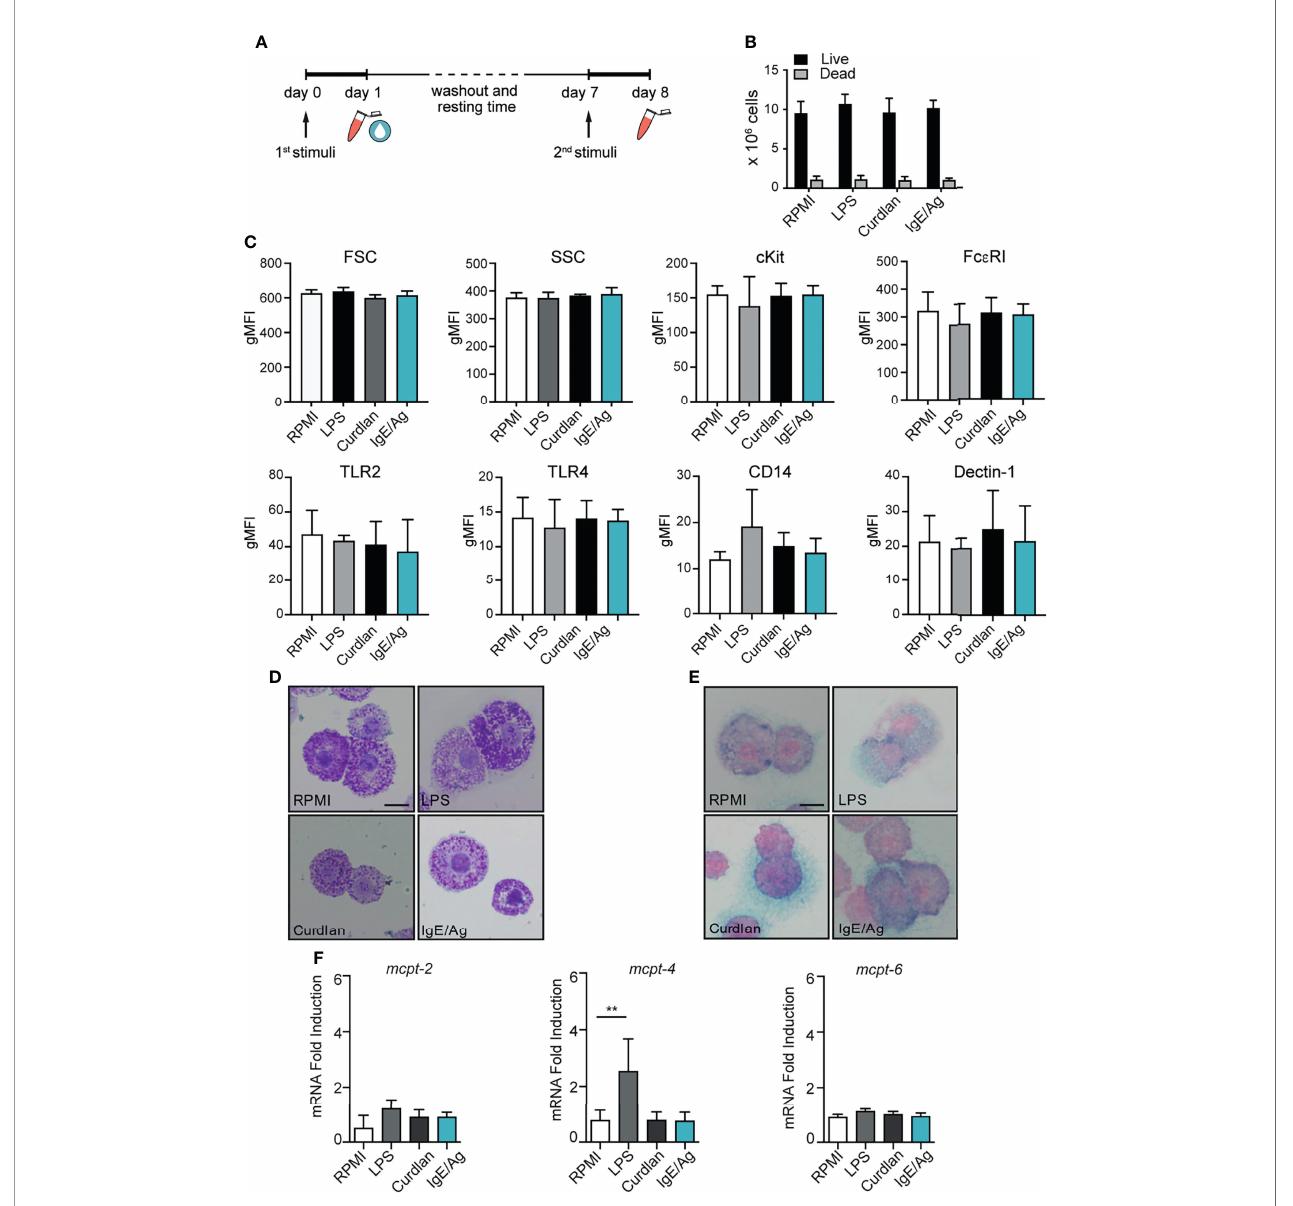
FIGURE 1 | MC vitality and phenotype after the conditioning period. (A) Schematic representation of experimental protocol. BMMC were fi rst stimulated for 24h with LPS, curdlan, IgE/Ag or left untreated (RPMI). Then cells were left to recover for 6 days, countedand tested for viability by means of trypan blue exclusion (B) , analyzed for surface marker expression (C) , stained with Toluidin blue (D) and Alcian-blu safranin (E) and analyzed for connective and mucosal proteases mRNA expression (F) . Data are expressed as mean +SD from n>3 experiments; statistical analysis were performed with one-way Anova with Dunnet correction (**p <